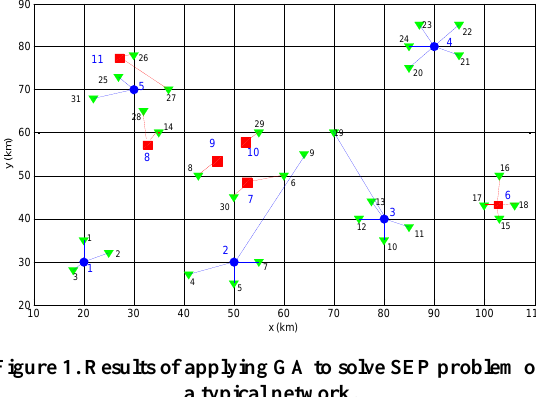
Figure 1. Results of applying GA to solve SEP problem on a typical network.